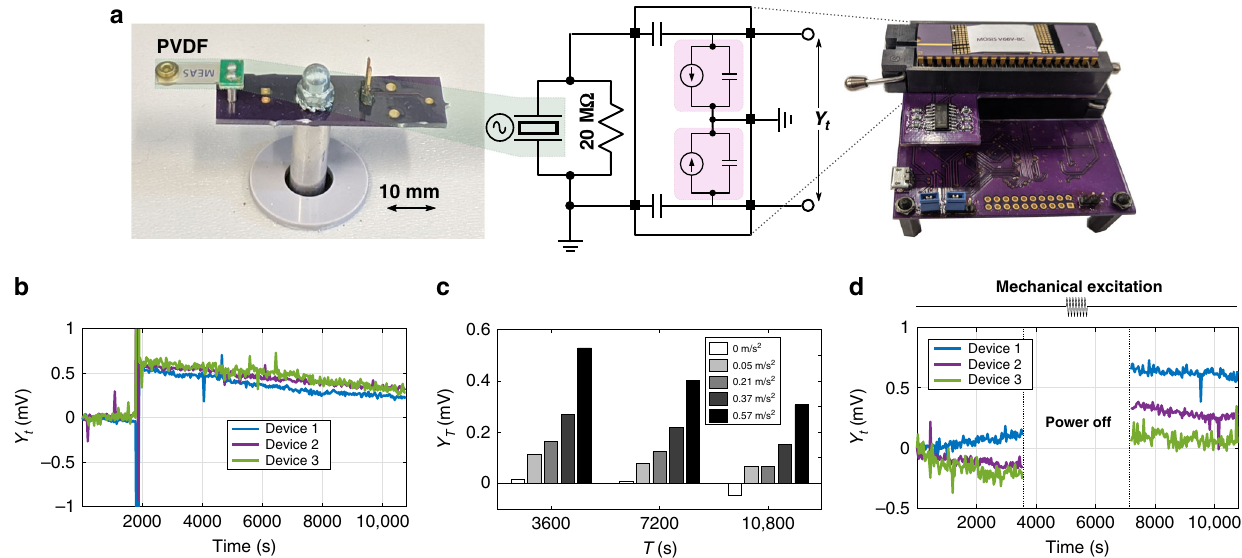
Fig. 5 Self-powered sensing and data logging of mechanical acceleration. a Experimental setup showing a piezoelectric (PVDF) transducer connected to the FN sensor-data-logger chipset. b Logger response when 58.6 mg (0.57 m/s 2 ) acceleration was applied to the piezo cantilever (gain of 6 V resonant frequency) at 72 Hz for 100 s. c Recorder responses at different readout times for a range of input frequencies. All modulated responses were statistically different from the unmodulated case at all readout times. d Recorder was powered off in the shaded region. During that time period, vibration table was actuated, which was recorded as evidenced by the recorder value when power supply was turned